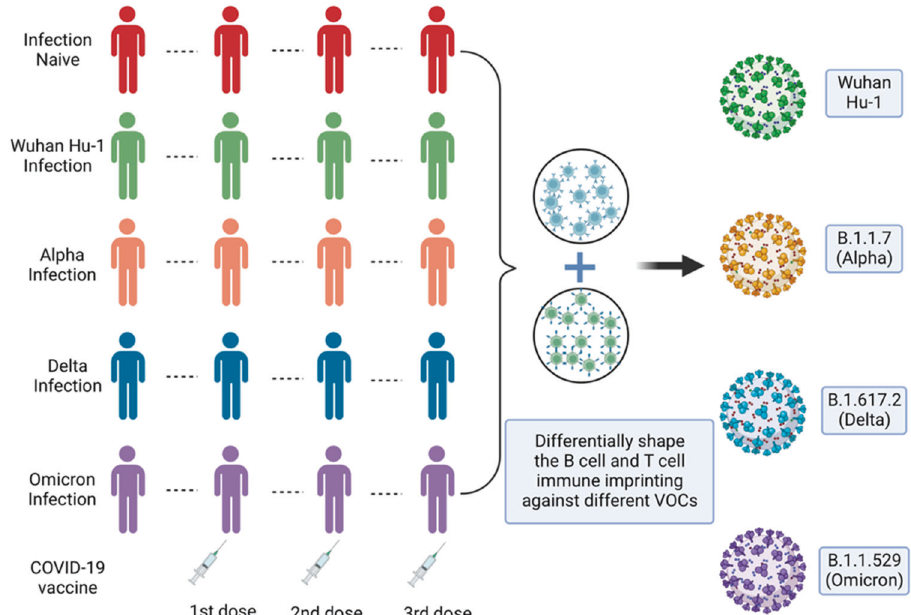
Fig. 1 SARS-CoV-2 infection history and Omicron infection alter and de fi ne T- or B-cell immunity in triple-vaccinated HCWs. Triple-vaccinated HCWs with different SARS-CoV-2 infection histories were examined for T- and B-cell immunity toward VOCs, including the Omicron. Different combinations of SARS-CoV-2 infection and vaccination led to distinct, imprinted patterns of hybrid immunity. Although hybrid priming by infection and vaccination was generally expected to enhance protective immunity, a combination of Wuhan Hu-1 or Alpha infection and three doses of vaccines had a negative effect on protective immunity against the Omicron infection. The precise molecular mechanism underlying the phenomenon, “ hybrid immune damping ” , should be elucidated for the future development of effective vaccines. This fi gure was generated based on ref.